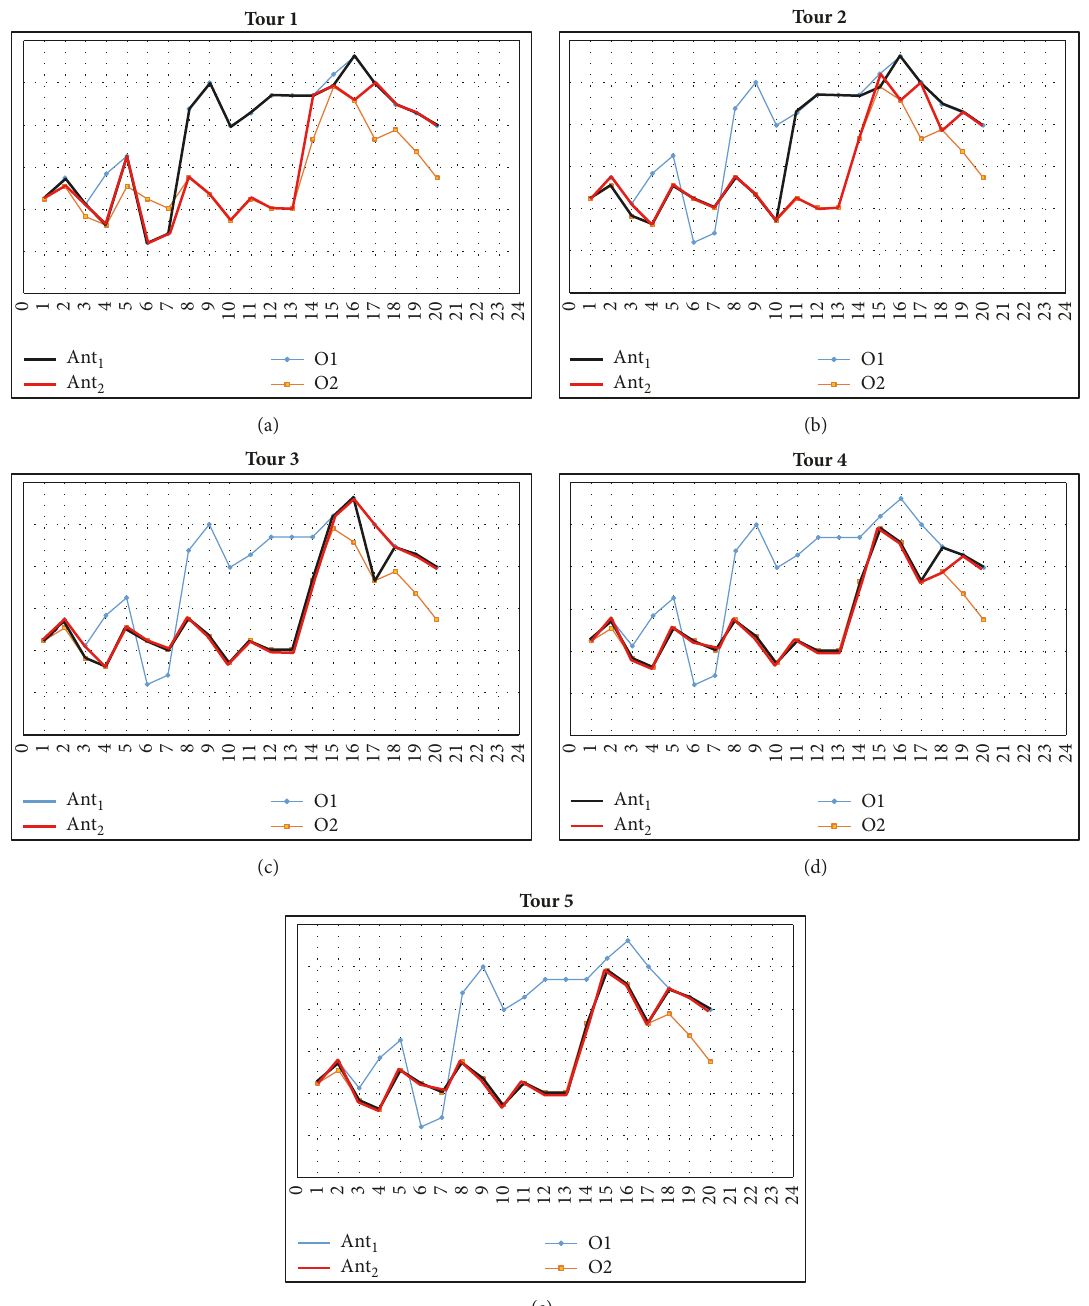
Figure 19: Optimization process of 2 ants during 5 iterations.